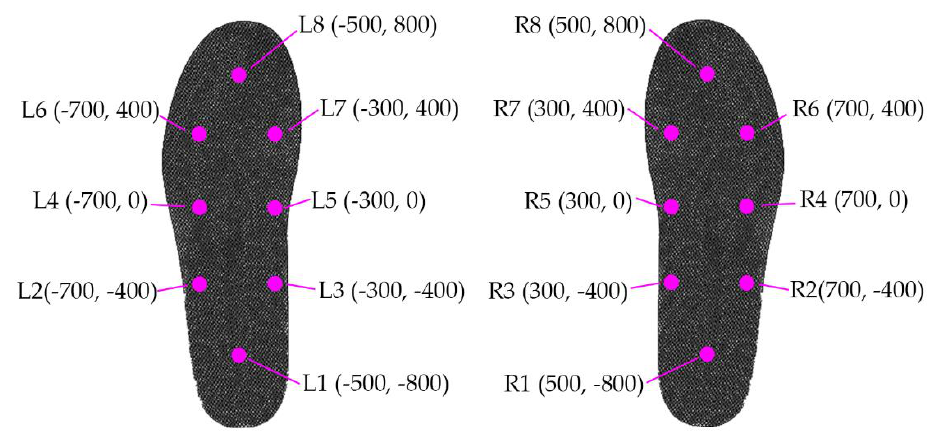
Figure 2. The pressure sensors L1–L8 and R1–R8 under the left and right feet, respectively. The sampling frequency of the force sensors was 100 Hz, and the forces (N) were collected to obtain a time series of pressure data. In addition to the pressure data, two synthetic signals were generated, including the total sum of the pressure under the left and right feet. The resulting data contain 19 columns per row, with column 1 as time (s); columns 2–9 and 10–17 as the GRF (N) of the left and right feet, respectively; and column 18 as the sum of the GRF on the left foot and column 19 as that for the right. These data were used to fit the relationship between the pressure position and time, model the reaction pressure center as a function of time, and obtain the gait features such as stride time, swing time, etc.